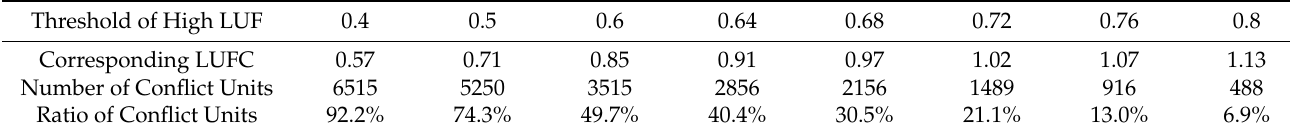
Figure 4. Probability density diagram of ( a ) the normalized land-use function suitability evaluation and ( b ) the land-use function suitability conflict. Table 2. Sensitivity analysis of the conflict units with different thresholds of land-use function suitability.